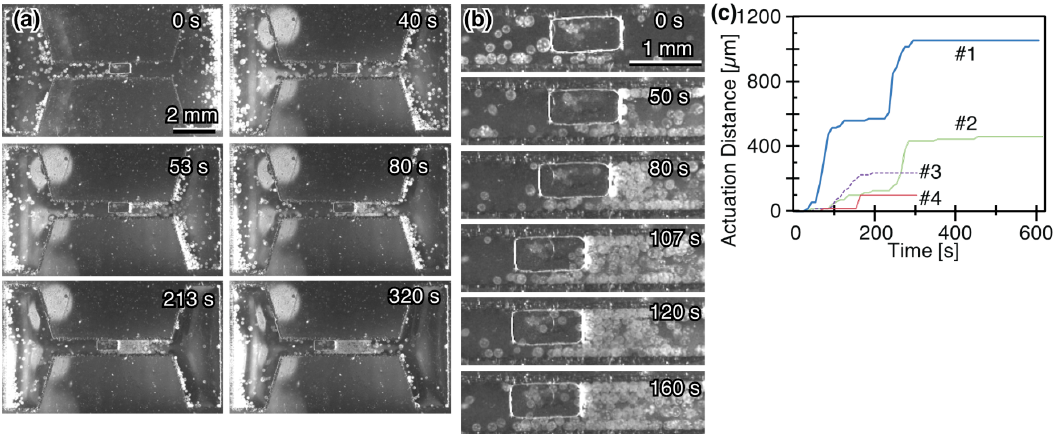
Figure 8. Placement of a 750 μ m width block in a 970 μ m width micro channel with tweezers.